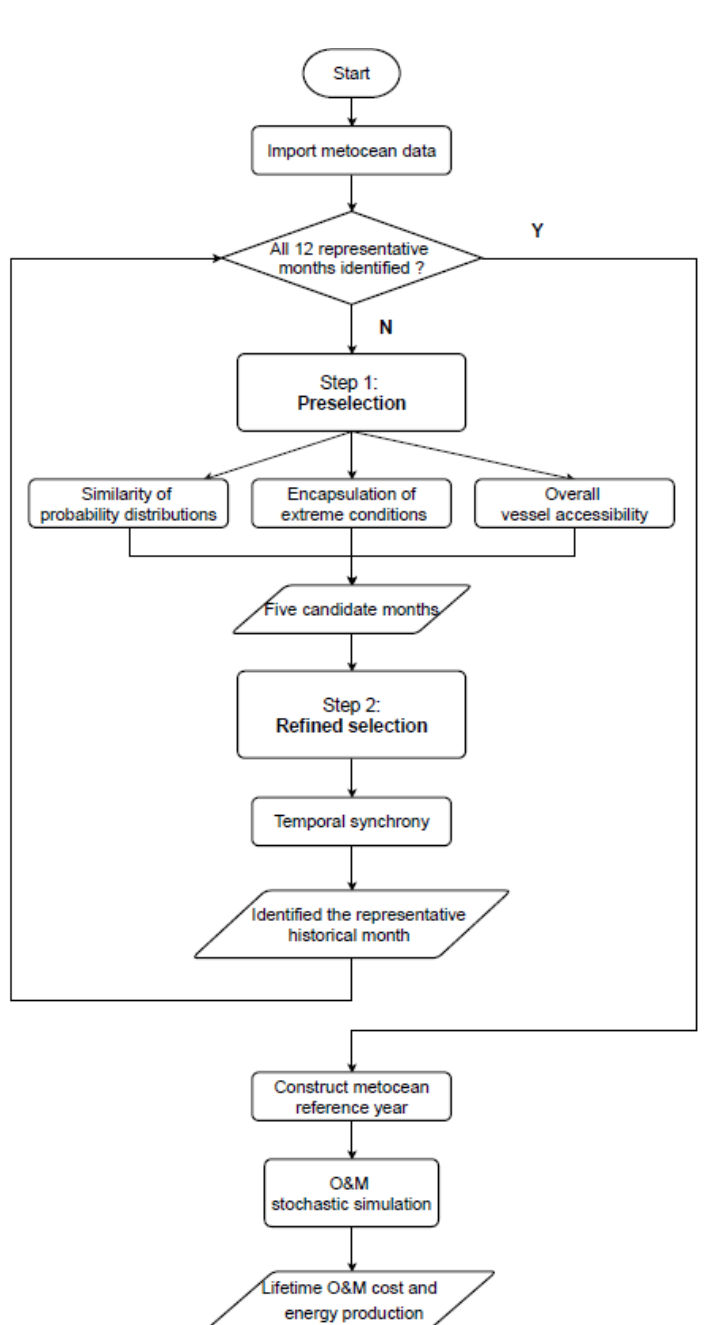
Figure 1. Schematic of the proposed hierarchical met-ocean data selection model.